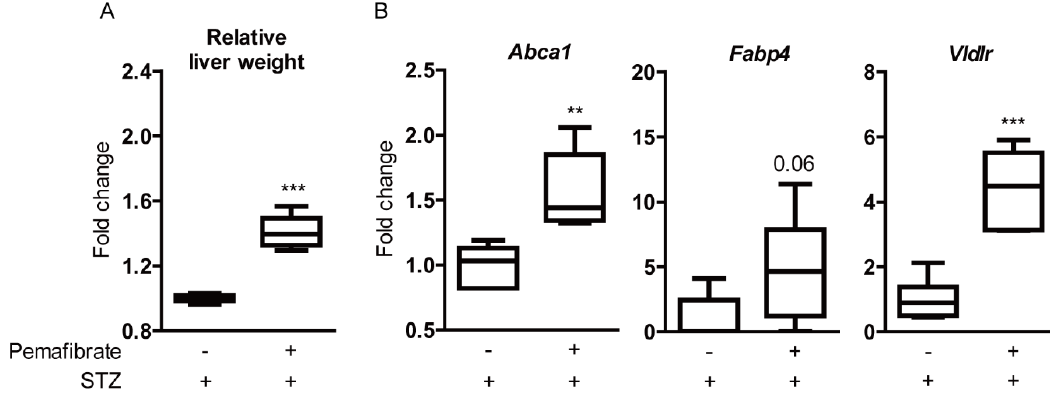
Figure 4. Increase of liver weight and PPARα downstream gene expression in the liver by